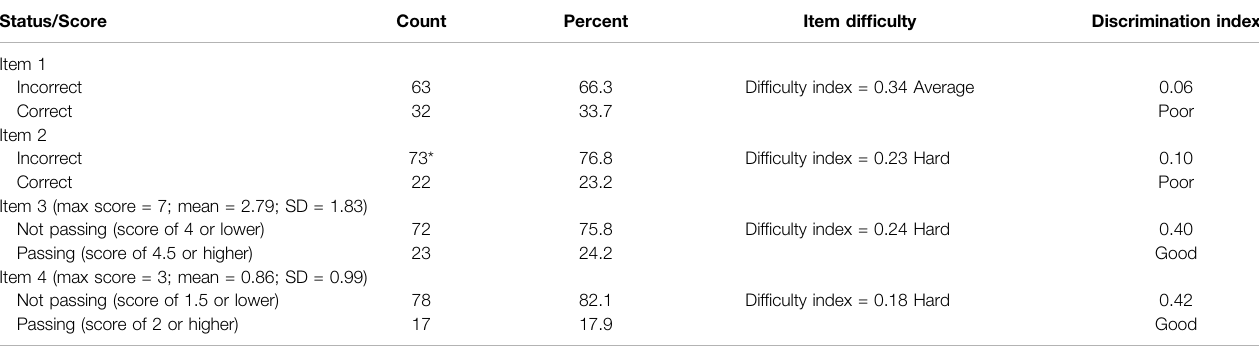
TABLE 8 | Unit 4 item